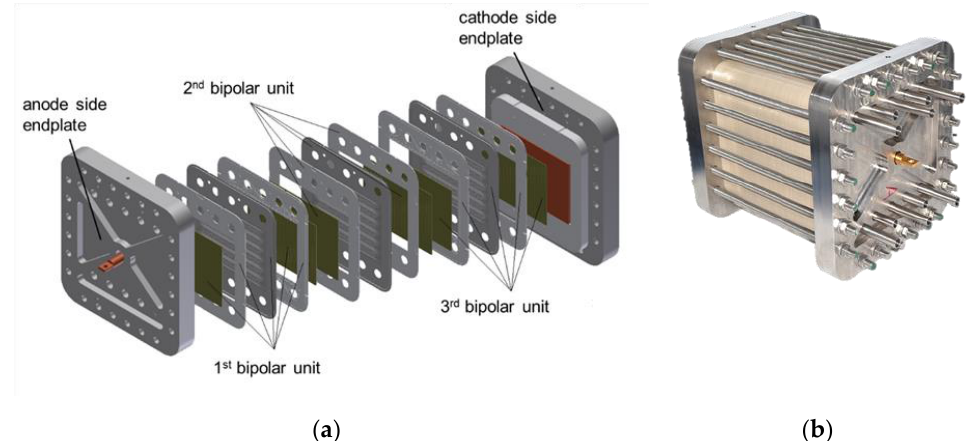
Figure 6. Electrolysis stack from the Ekolyser project; ( a ): Exploded view with three bipolar units; ( b ): 27-cell stack, 50 kW el , 50 bar.